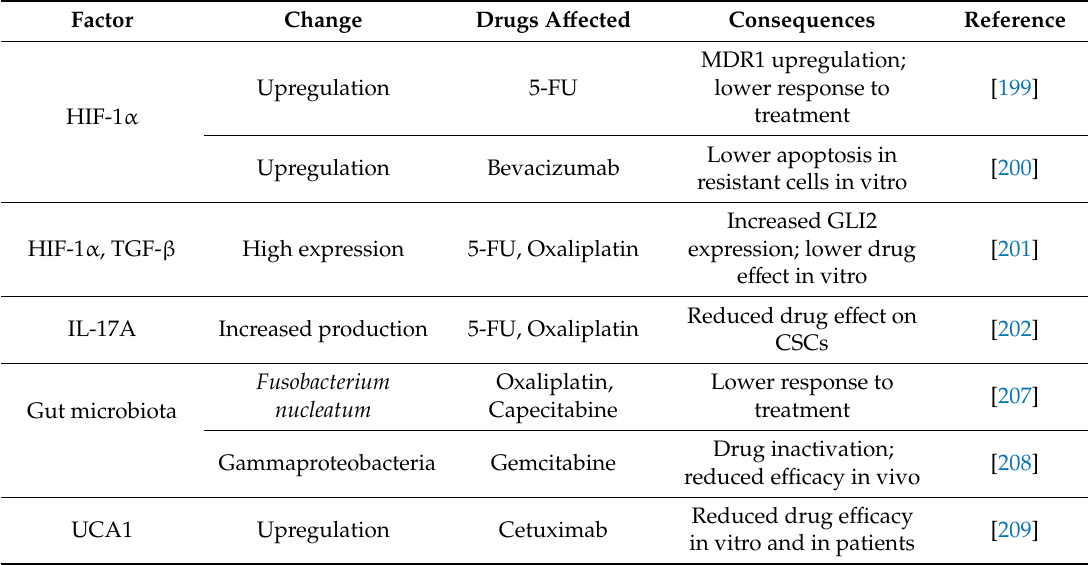
Table 6. Mechanisms of resistance type 6 (MOC-6) in colorectal